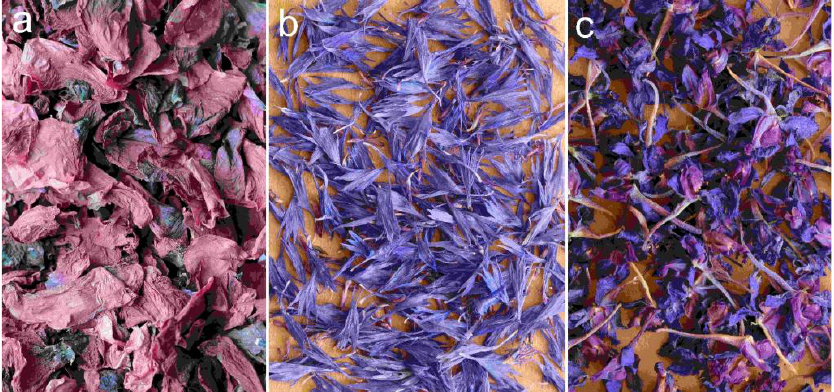
Figure 2. Traditional medicinal products from the three studied species, including ( a ) dried petals of corn poppy ( Rhoeados flos ); ( b ) ray florets of cornflower ( Cyani flos ); and ( c ) tepals of field larkspur ( Calcatrippae flos ) (Photographs by Gyula Pinke).